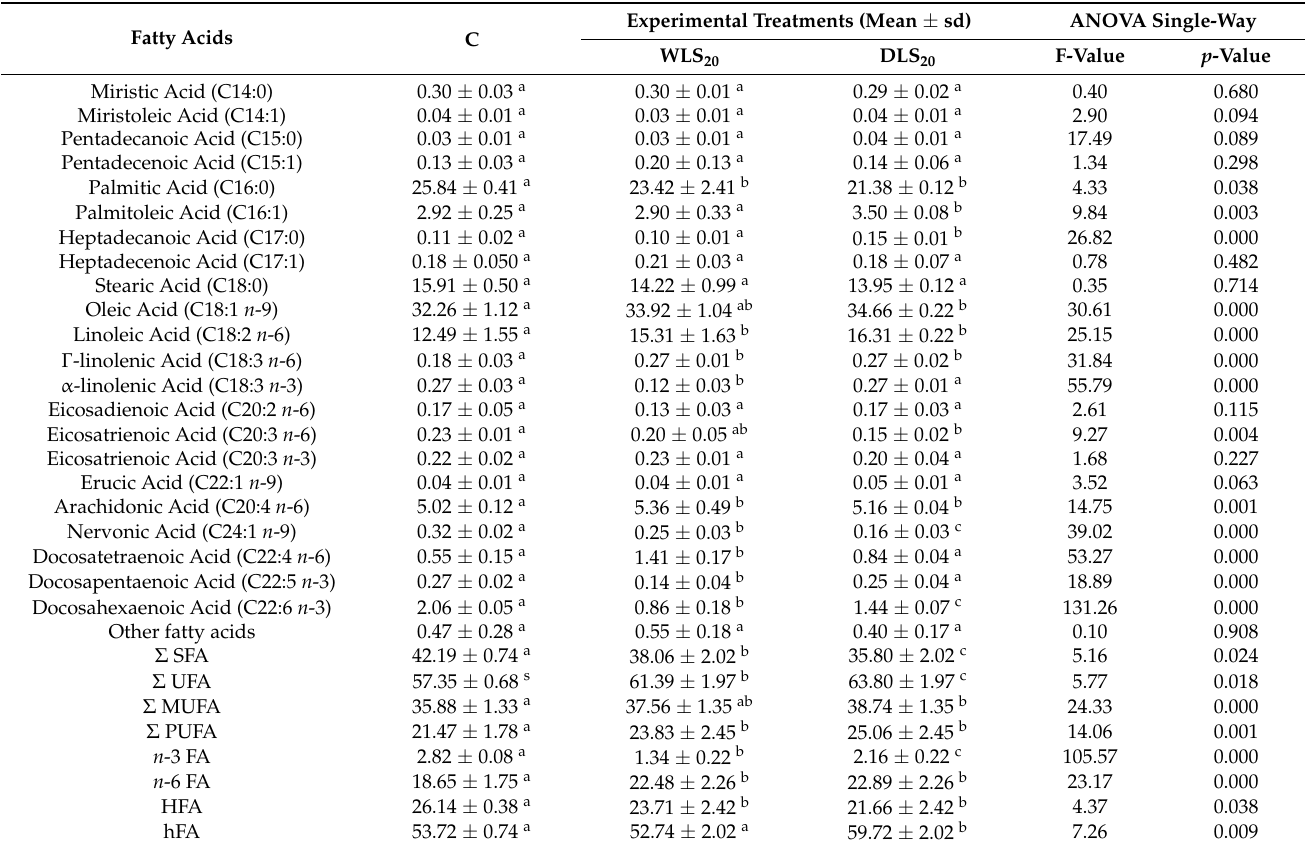
Table 7. Influence of dehulling white lupine seeds used in the laying quail diets on the fatty acids profile of fats from egg yolk (% of